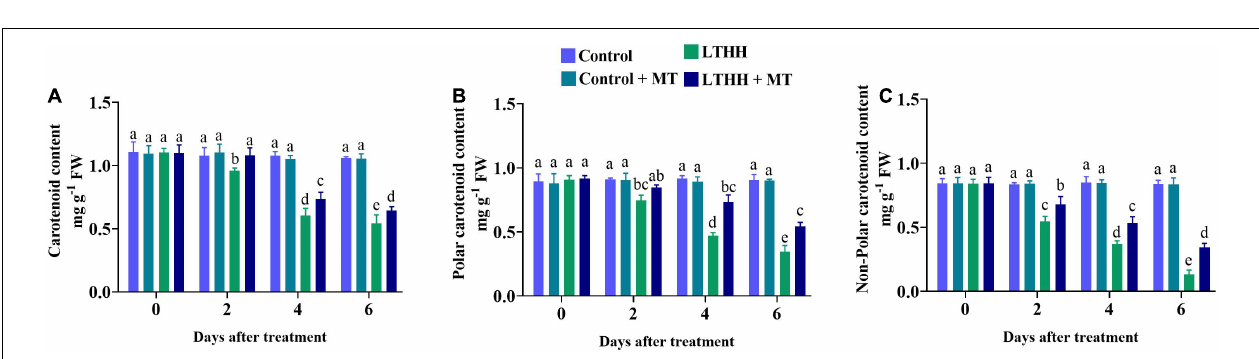
FIGURE 5 | Effect of exogenous melatonin on chlorophyll a (A) , and chlorophyll b (B) content of cucumber seedling under low-temperature and high-humidity stress. Control (25/18 ◦ C); Control + MT (200 µ M melatonin, 25/18 ◦ C); LTHH (15/10 ◦ C, 95%); LTHH + MT (200 µ M melatonin, 15/10 ◦ C, 95%). Same letters on the bars represent no significant differences, while different letters represent significant differences among treatments ( P > 0.05 was non-significant). Data are means ± SD of three replicates ( n = 3).